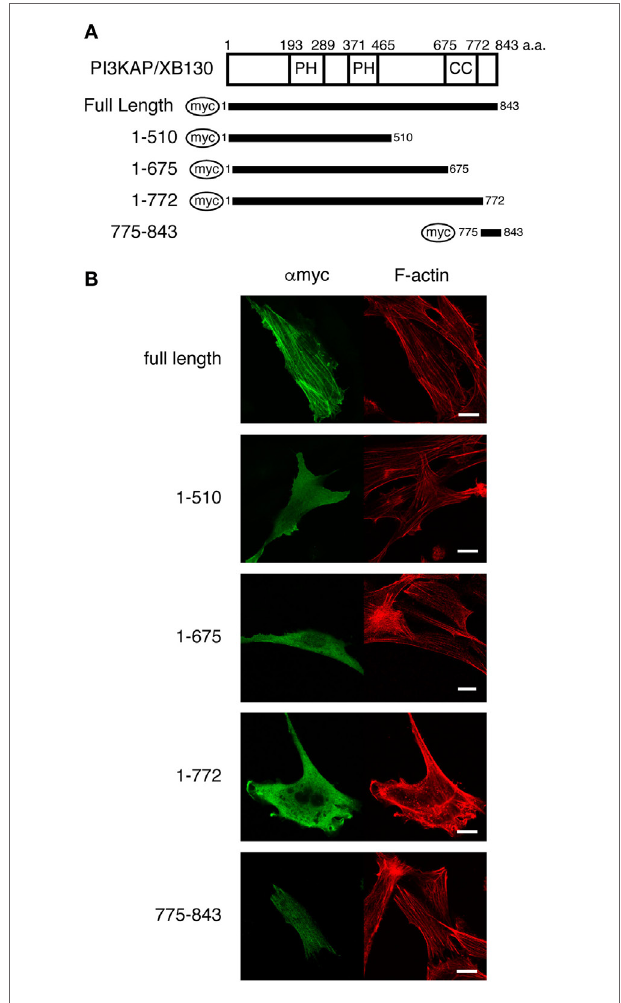
FigUre 1 | Pi3KaP/XB130 is localized to actin filaments . (a) The myc-tagged PI3KAP/XB130 deletion constructs used in the experiments are shown. The numbers indicate the amino acid residues from the N-terminal end of PI3KAP. PH, PH domain; CC, coiled-coil domain. (B) Myc-tagged PI3KAP/XB130 or deletion mutants were transfected into NIH3T3 cells. Fixed and permeabilized cells were stained with anti-myc antibody and TRITC- labeled phalloidin. Myc-tagged proteins were visualized by Alexa488 in green in the confocal microscopy. F-actin was visualized in